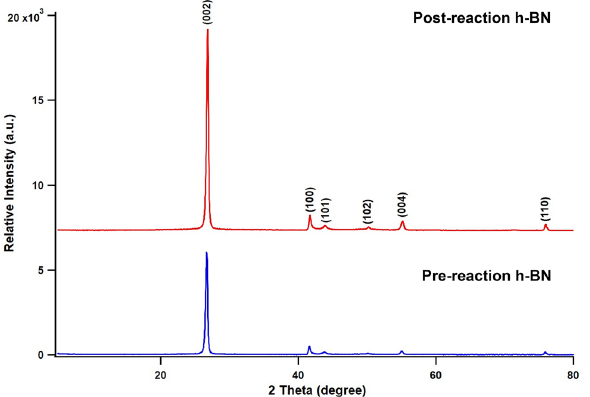
Figure 7. X-ray diffraction analysis of pre- and post-reaction h-BN. Reaction conditions used; 400 mg h -BN, 118 mmol